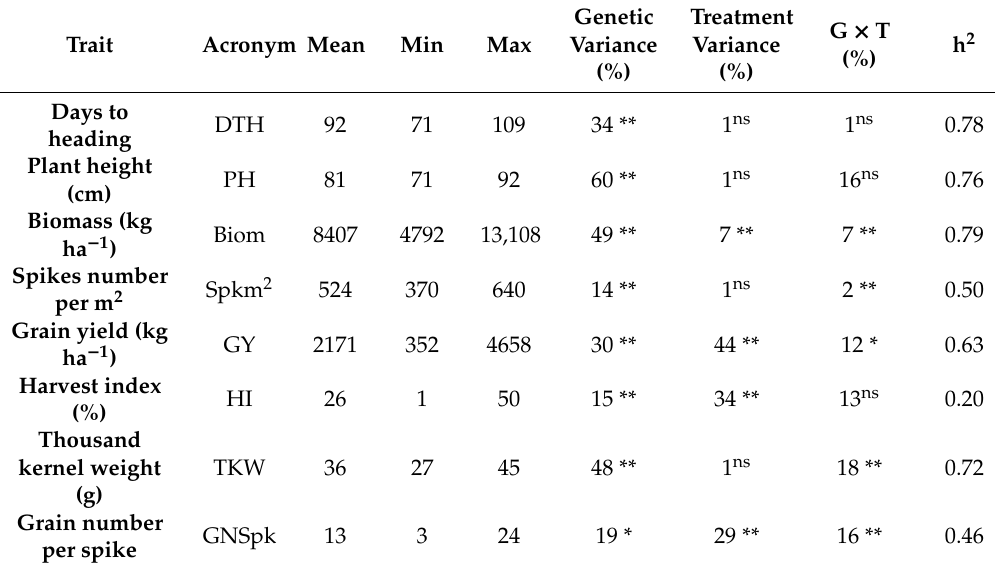
Table 1. Descriptive statistics, component of trait variation, and heritability (h 2 ) among a set of 42 durum genotypes (G) tested under two treatments (T): normal and plastic tunnel-mediated heat stress during seasons 2015–2016 and 2016–2017.